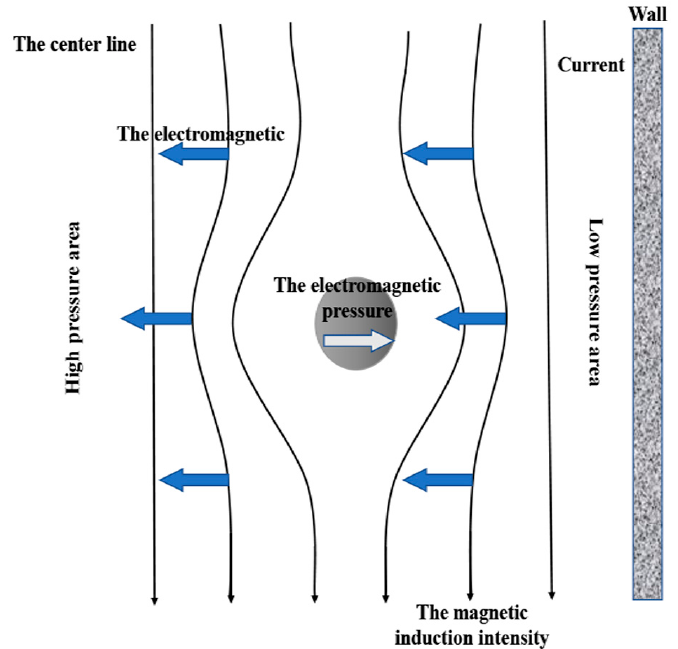
Figure 8. Schematic of electromagnetic pressure [74].